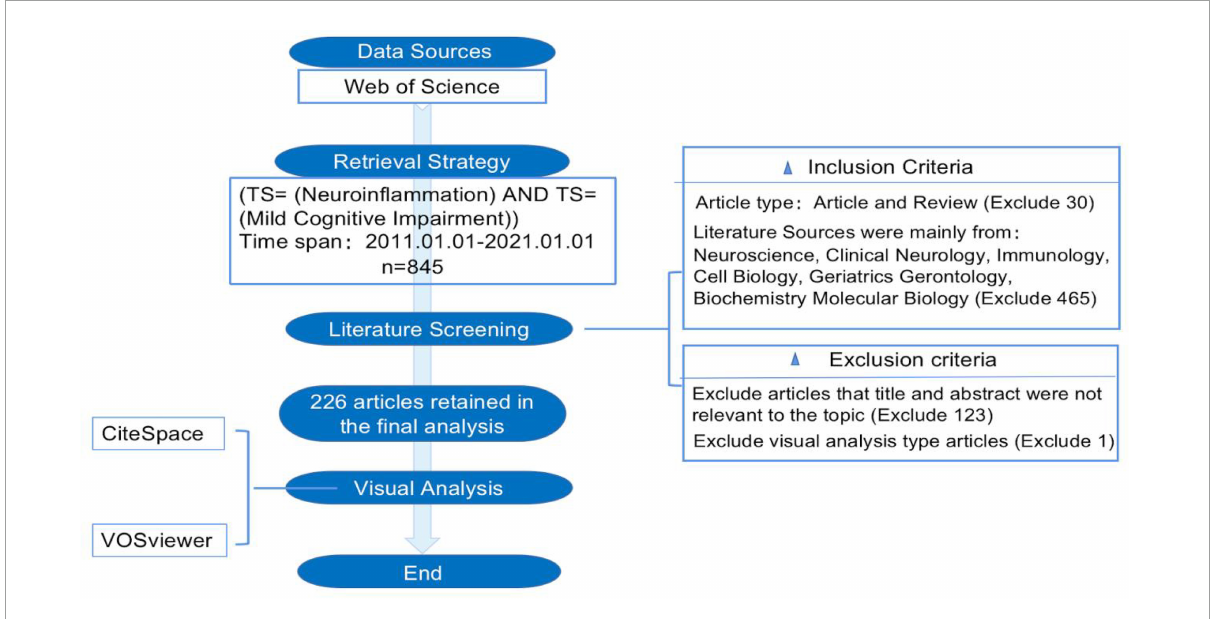
FIGURE1 Flow chart for inclusion in literature